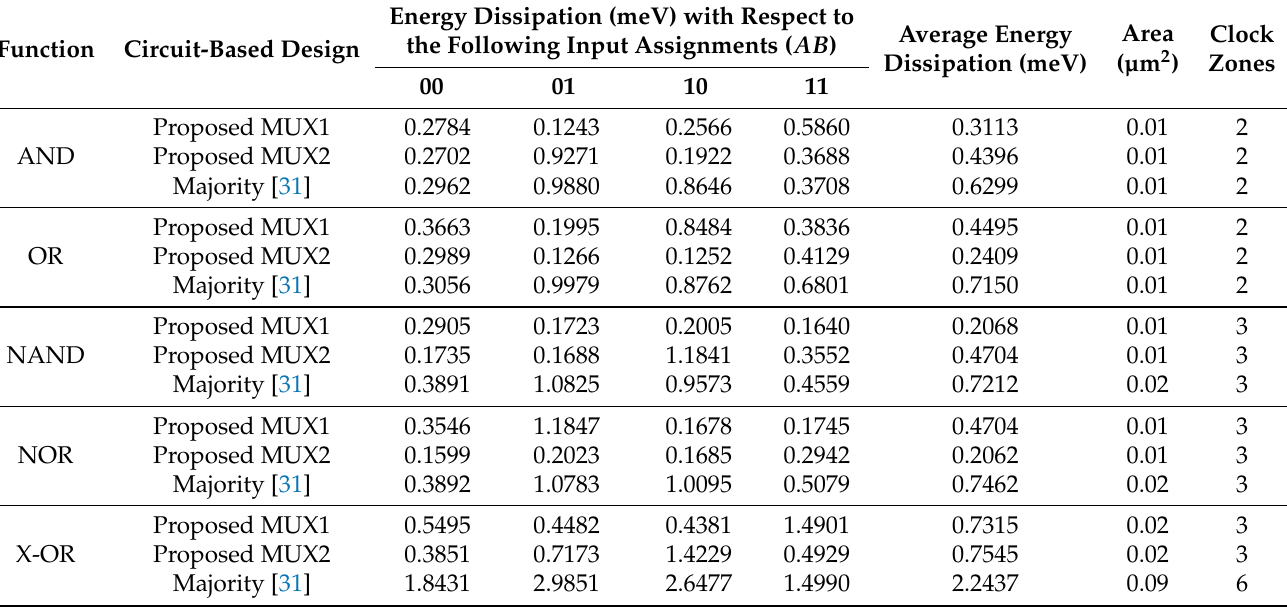
Table 4. Comparison of basic logic functions using the proposed 2 × 1 MUX with existing majority-based designs.